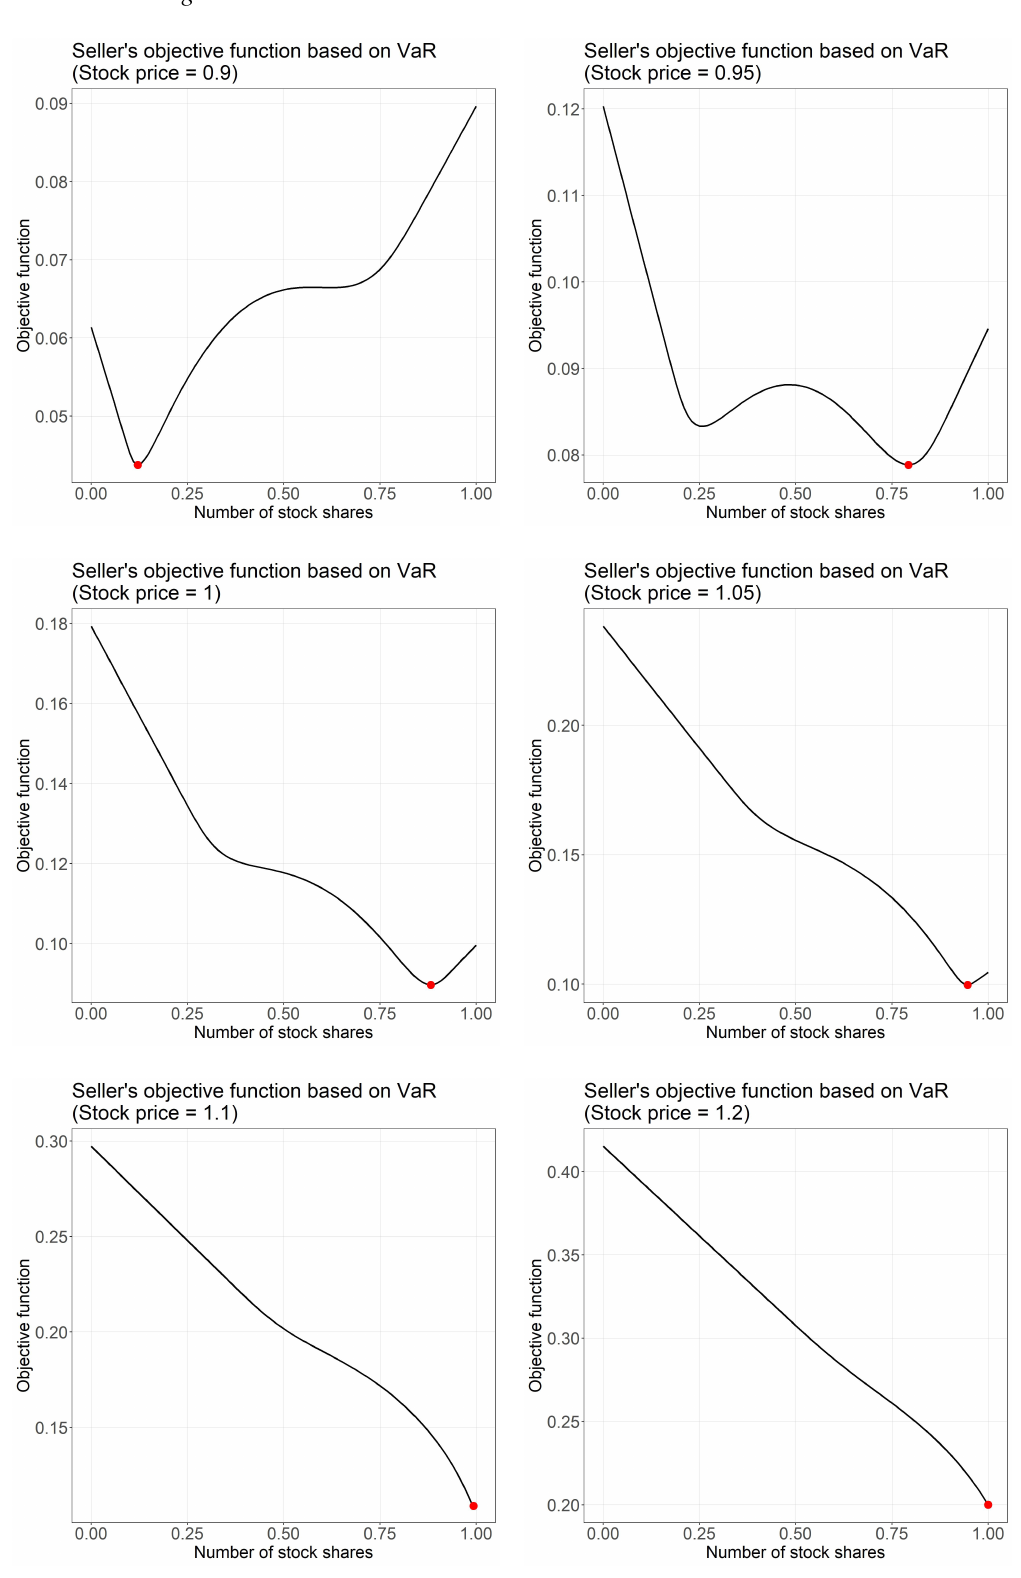
Figure 4. Seller’s objective function for different stock